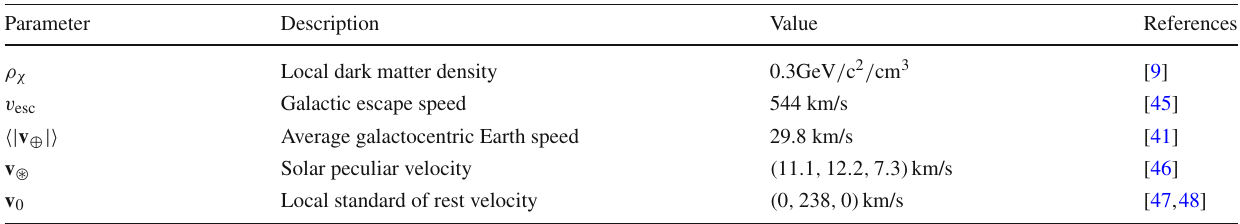
Table 1 Suggested Standard Halo Model parameters. Vectors are given as (v r ,v φ ,v θ ) with r pointing radially inward and φ in the direction of the Milky Way’s rotation. Analyses insensitive to annular modulation can approximate v (cid:3) ( t ) with Eq. 12